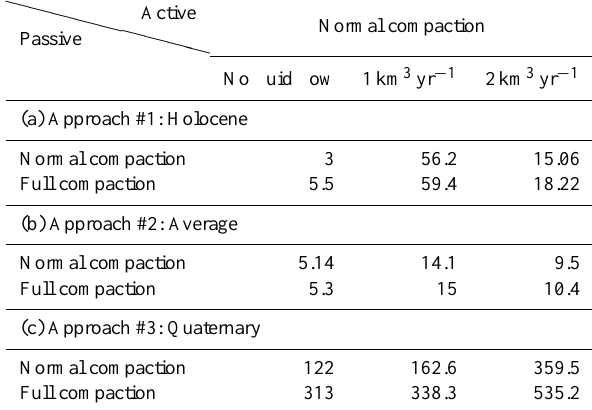
Table 4. Global gas hydrate estimations (GH FF ) in GtC, for the dif- ferent approaches of SR and POC input (Holocene, Quaternary and the average over geological times). The results of different degrees of compaction at passive margins (normal or full), as well as of dif- ferent fluid velocities at active margins (0.01 and 0.02cmyr − 1 ) are shown. For all calculations, Hamza’s heat flow values were used to estimate the thickness of the GHSZ. At active margins, a volume of 1km 3 yr − 1 of expelled water corresponds to a fluid velocity